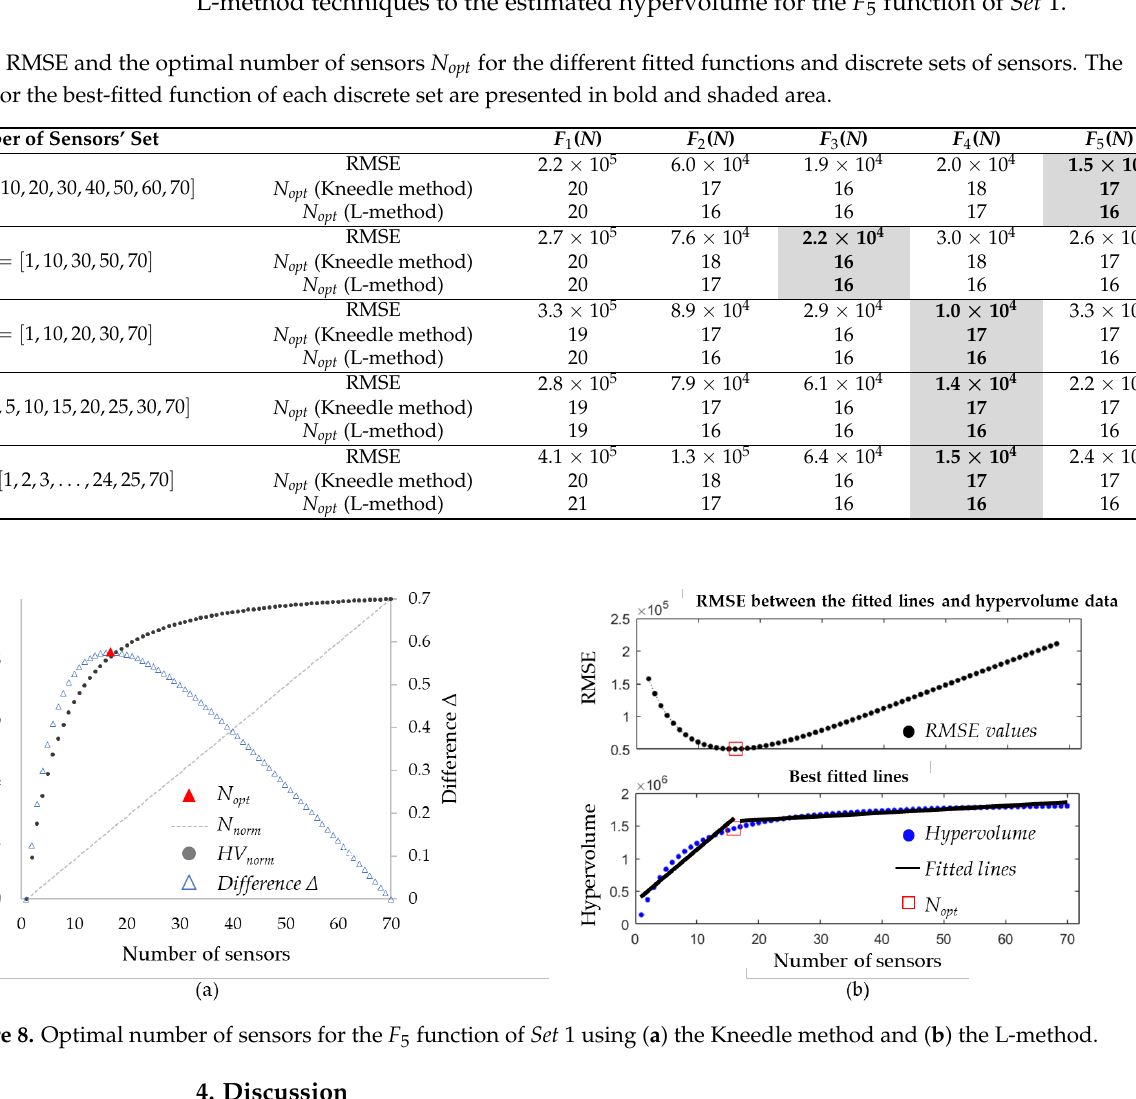
Figure 7. Estimated hypervolume values using different fitted functions F i and different discrete sets of numbers of sen- sors.